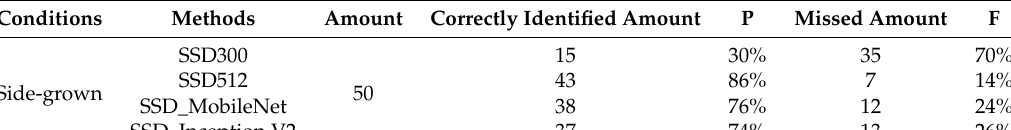
Figure 7. The detection results of uneven illumination cherry tomatoes. ( a ) the result of SSD300 model, ( b ) the result of SSD512 model, ( c ) the result of SSD_MobileNet model and ( d ) the result of SSD_Inception V2 model. Table 5. The detection results of different methods under side-grown condition.